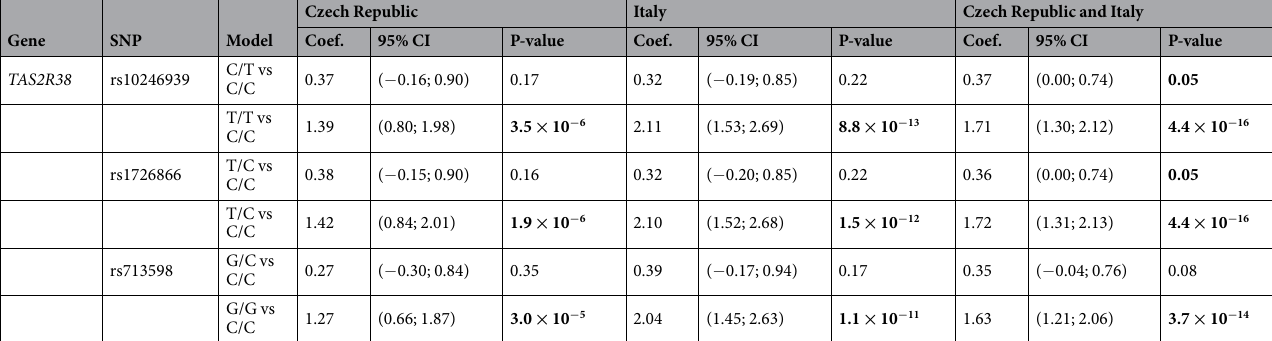
Table 2. Associations between TAS3R38 SNPs and PROP phenotype.